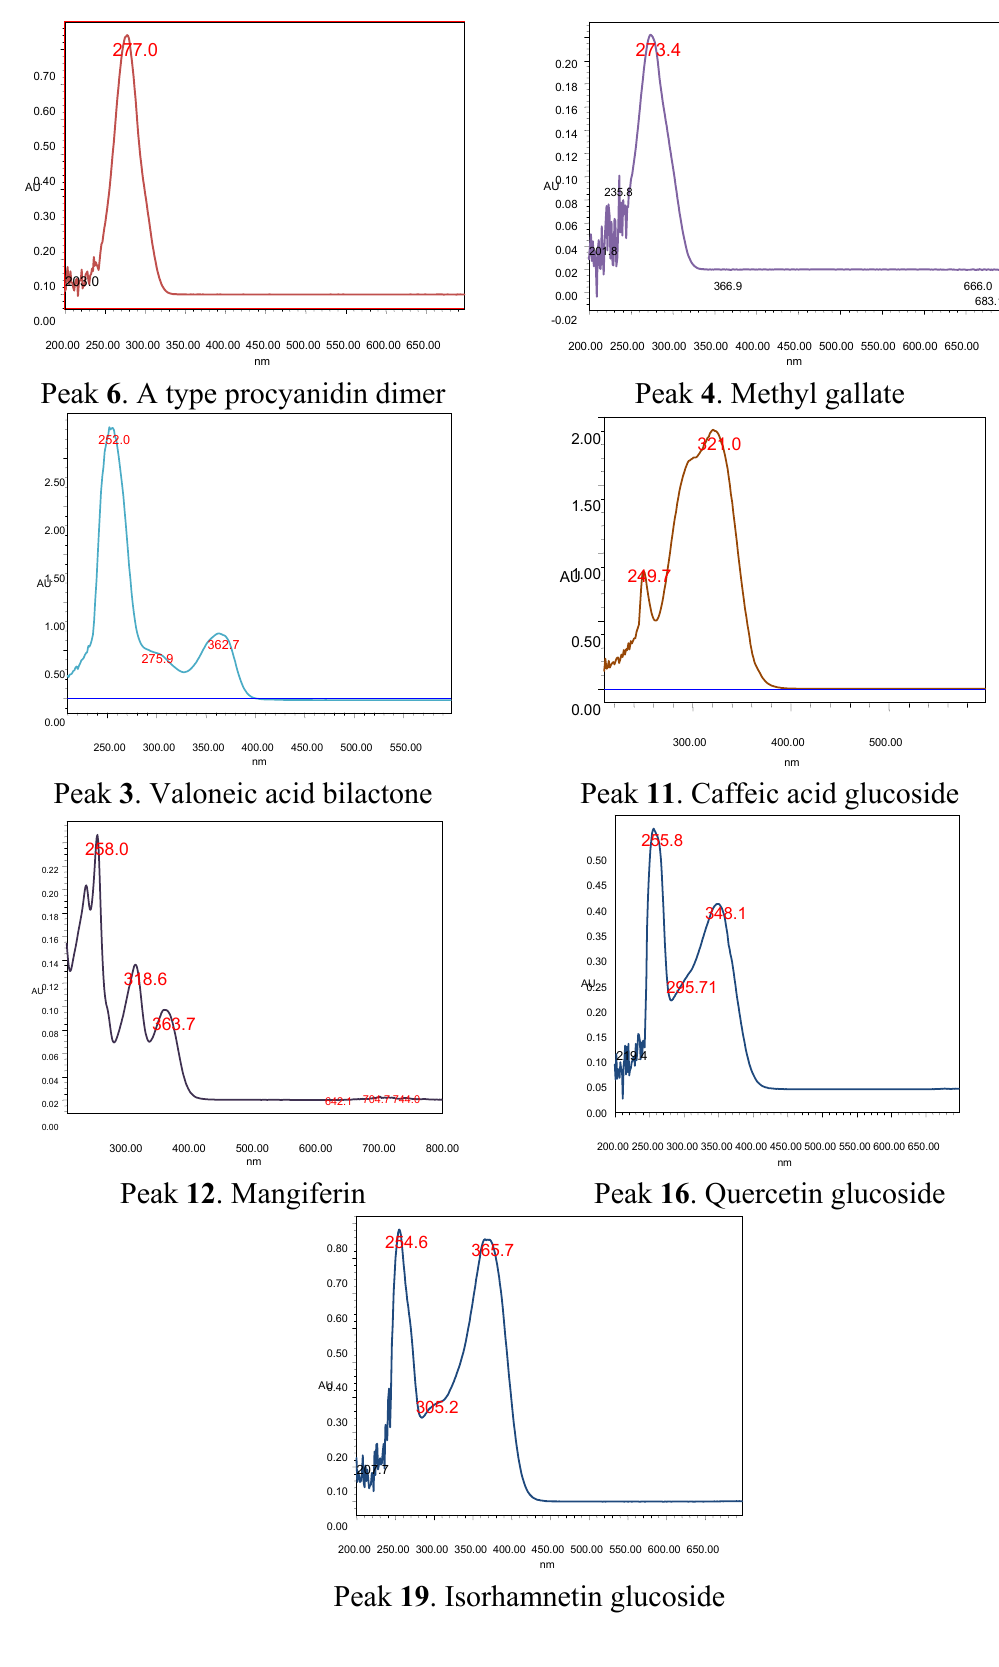
Figure 5. PDA spectra of compounds 3 , 4 , 6 , 11 , 12 , 16 and 19